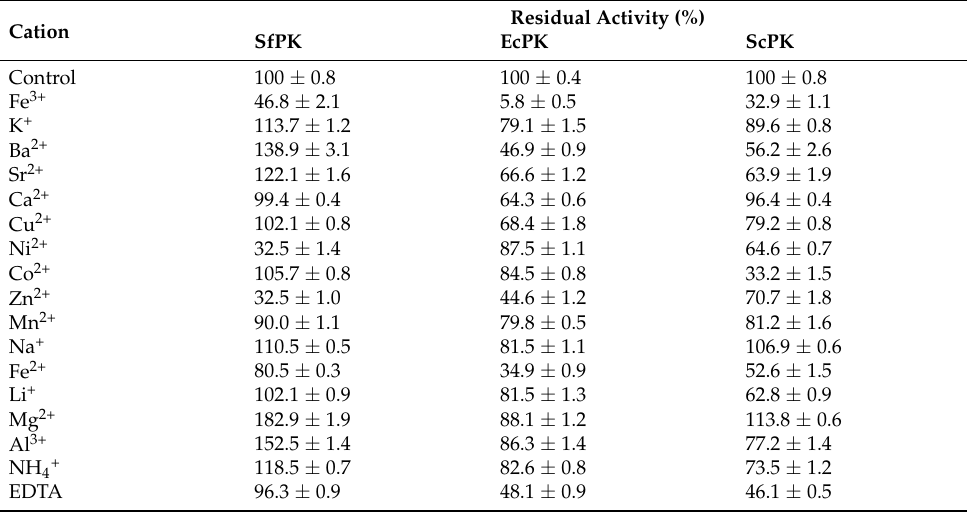
Table 2. Effects of cations and EDTA on the activity of SfPK, EcPK, and